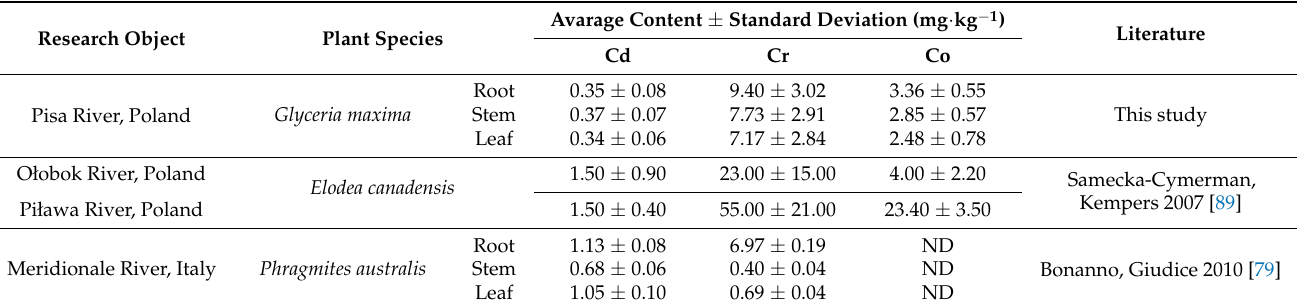
Table 5. Comparison of the results of PTEs content in macrophytes for other rivers of the world. Research